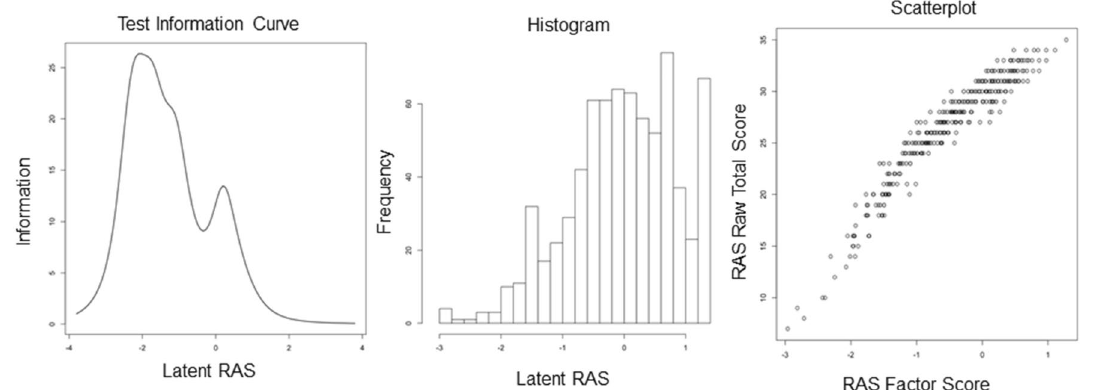
Figure 2. Test information curve for the Polish RAS, histogram of relationship satisfaction factor scores, and a scatterplot of raw v. factor scores for the Polish sample. n = 733. RAS Relationship Assessment